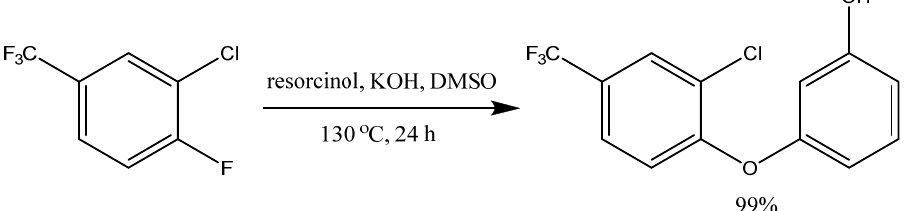
Scheme 11. Synthesis of 3-[2-chloro-4-(tri fl uoromethyl)phenoxy]phenol.